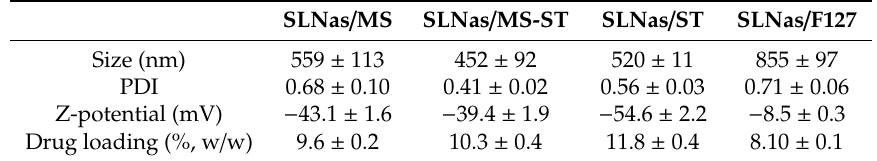
Figure 1. SLNas images by transmission electron microscopy. Table 1. Size, PDI, Z-potential, and drug loading levels of the SLNas samples (mean values ± SD)